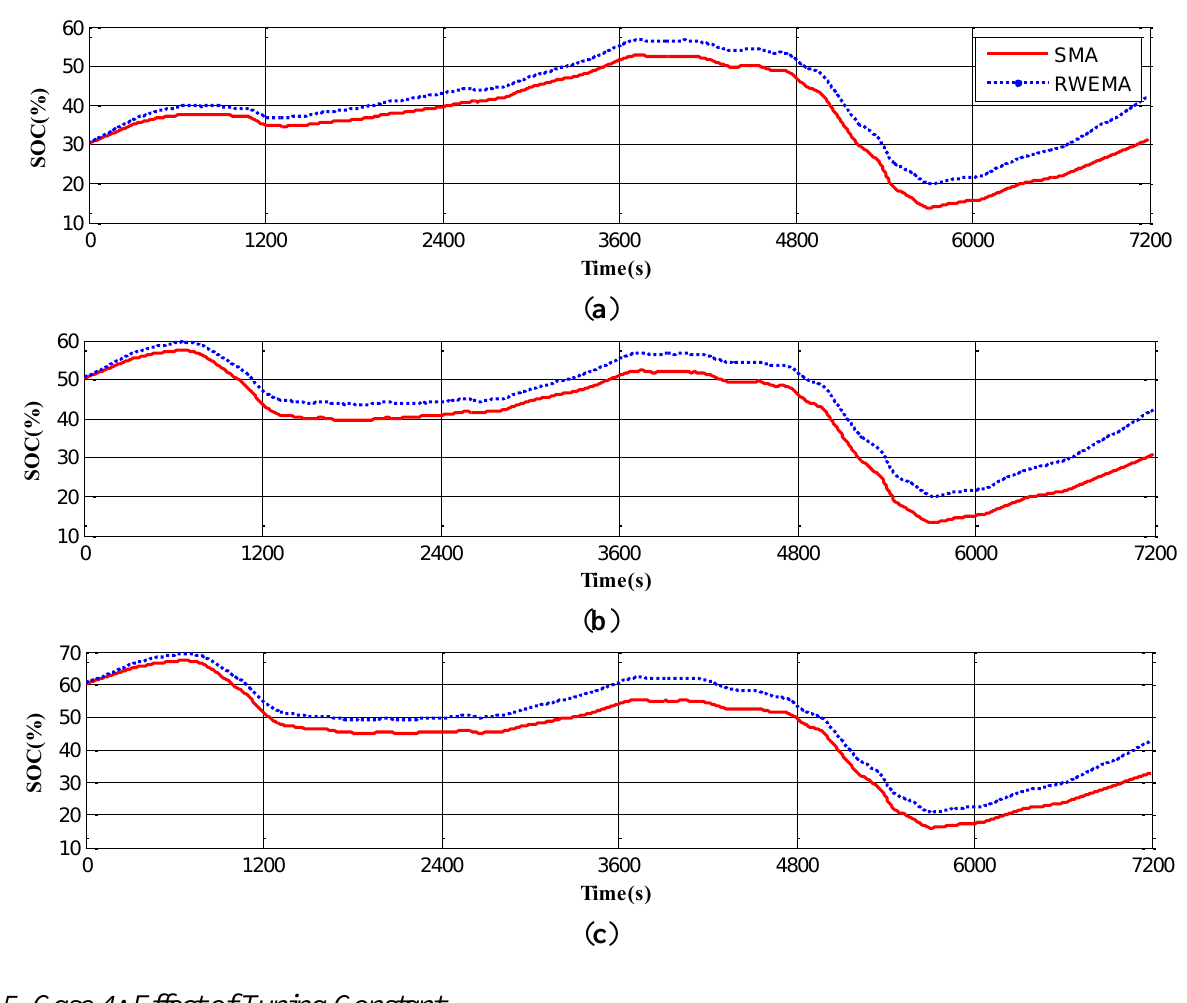
Figure 14. SOC level of NB with different initial values: ( a ) initial SOC = 30%; ( b ) initial SOC = 50%; and ( c ) initial SOC =